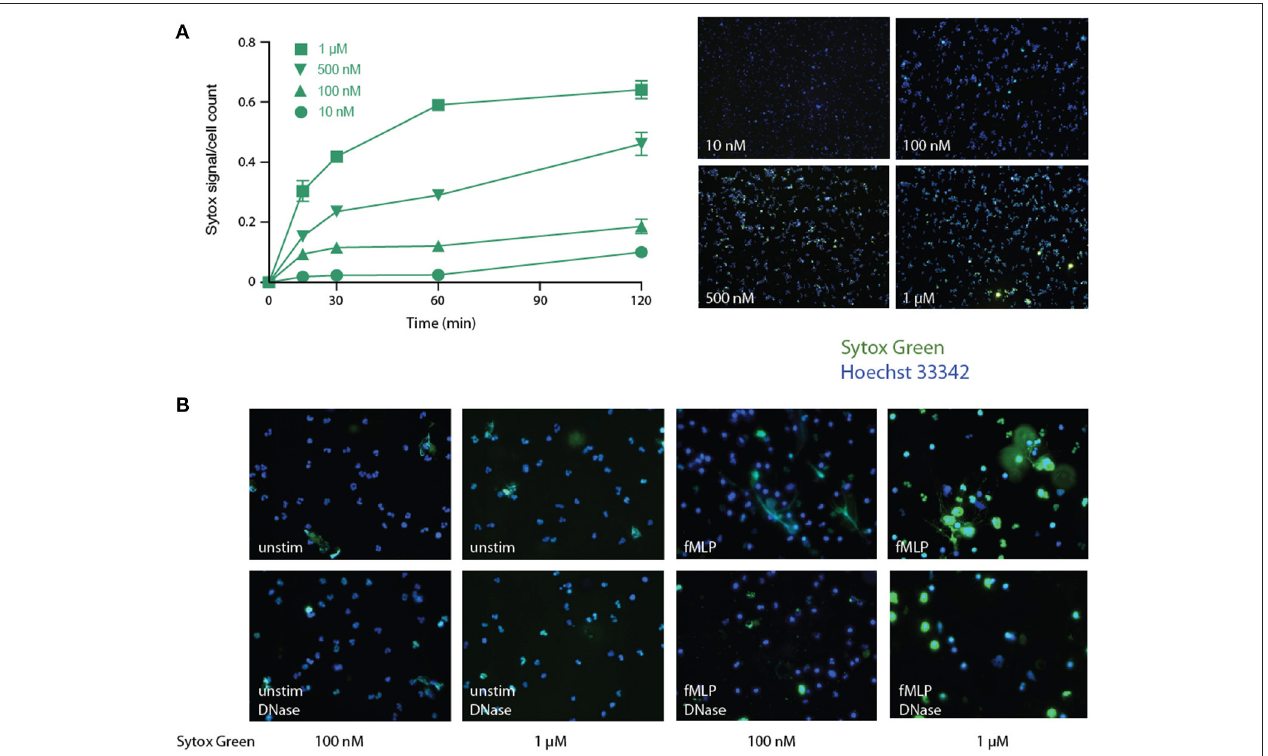
FIGURE 1 | Detection of NETs using Sytox Green in human neutrophils. (A) Unstimulated neutrophils were cultured in suspension for the indicated times in the presence of increasing concentrations of Sytox Green, prior to the addition of Hoechst 33342 and subsequent fluorescence microscopy analysis of unfixed cells. Total Sytox Green fluorescence values were divided by total Hoechst 33342 fluorescence, to normalize for cell number. Mean ± s.e.m. from duplicate measurements for each experimental condition from a representative experiment, shown on the right at 10X magnification. (B) Neutrophils were cultured for 4h on poly-L-lysine coated coverslips with the indicated Sytox Green concentrations, in the absence (“ctrl”) or presence of 30nM fMLP. The cells were then digested or not with DNase I (100 U/ml, 30min, 37 ◦ C), then stained with Hoechst 33342, prior to fluorescence microscopy analysis. A representative experiment is shown (at 40X